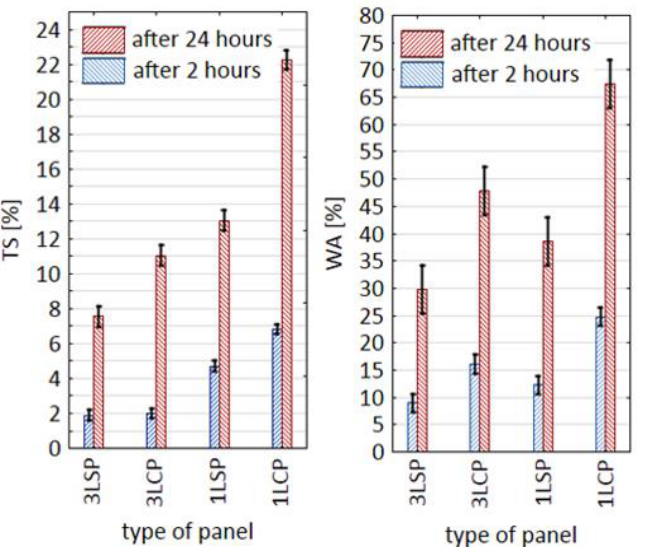
Figure 11. Thickness swelling (TS) and water absorption (WA) of produced particleboards (PBs). 3LCP—three-layer cup-plant PB, 3LSP—three-layer spruce PB, 1LCP—single-layer cup-plant PB, and 1LSP—single-layer spruce PB.